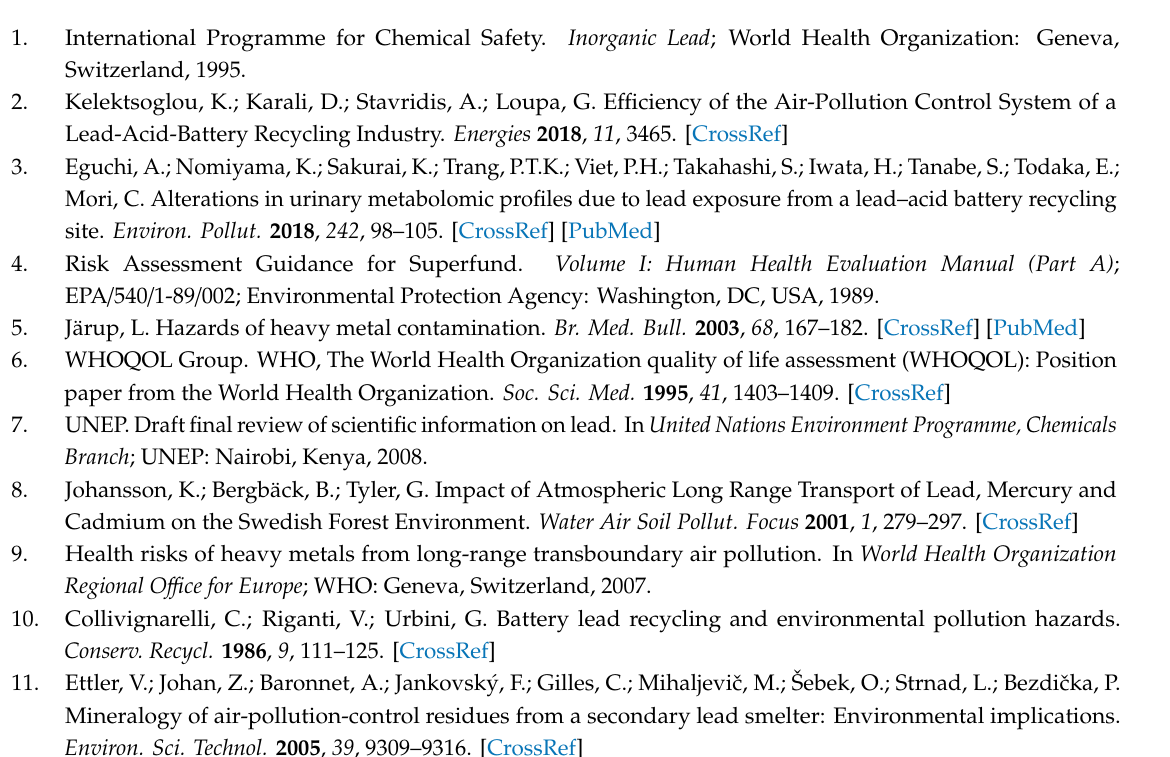
Table S1: Annual average concentrations of Pb arriving at the 72 discrete residential areas in the region of study for two scenarios, Table S2: Highest hourly values of Pb arriving at the 72 discrete residential areas in the region of study for two